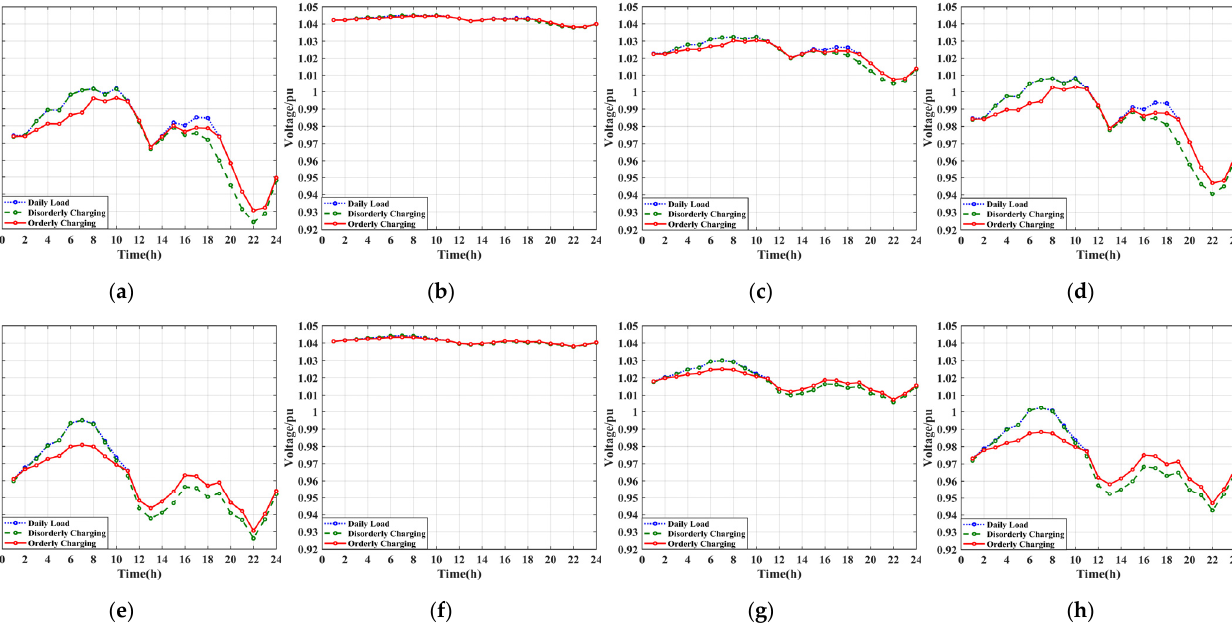
Figure 8. Voltage of nodes 18, 22, 25, and 33: ( a ) Node 18 (weekday), ( b ) Node 22 (weekday), ( c ) Node 25 (weekday), ( d )